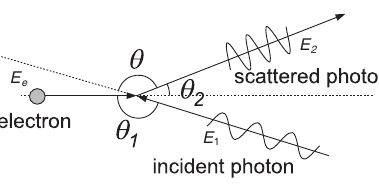
FIG. 2. A schematic view of laser Compton scattering.